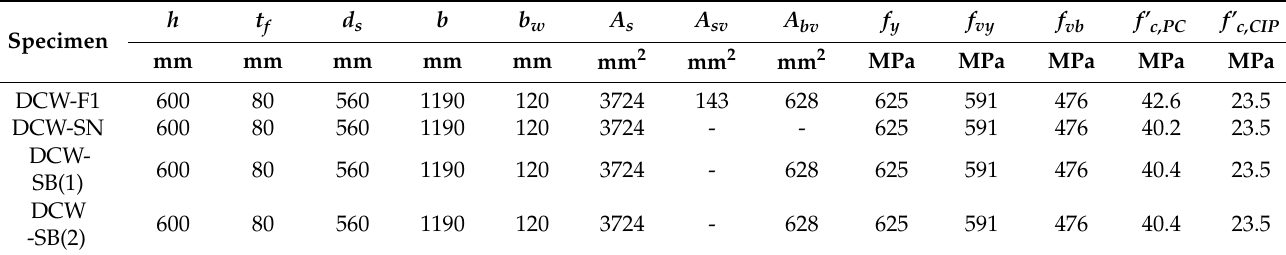
Table 1. Dimensions and material properties of the test specimens.